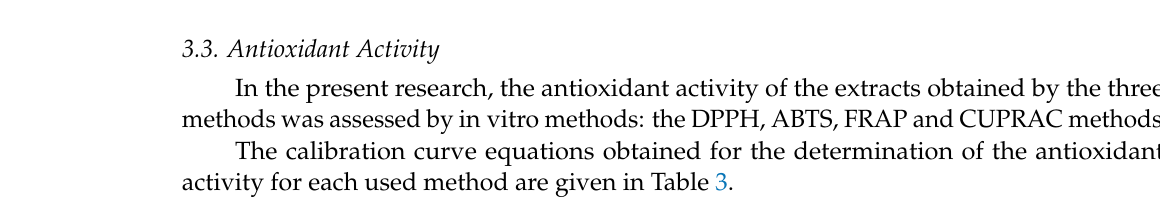
Table 3. Calibration curve relationships for the determination of antioxidant